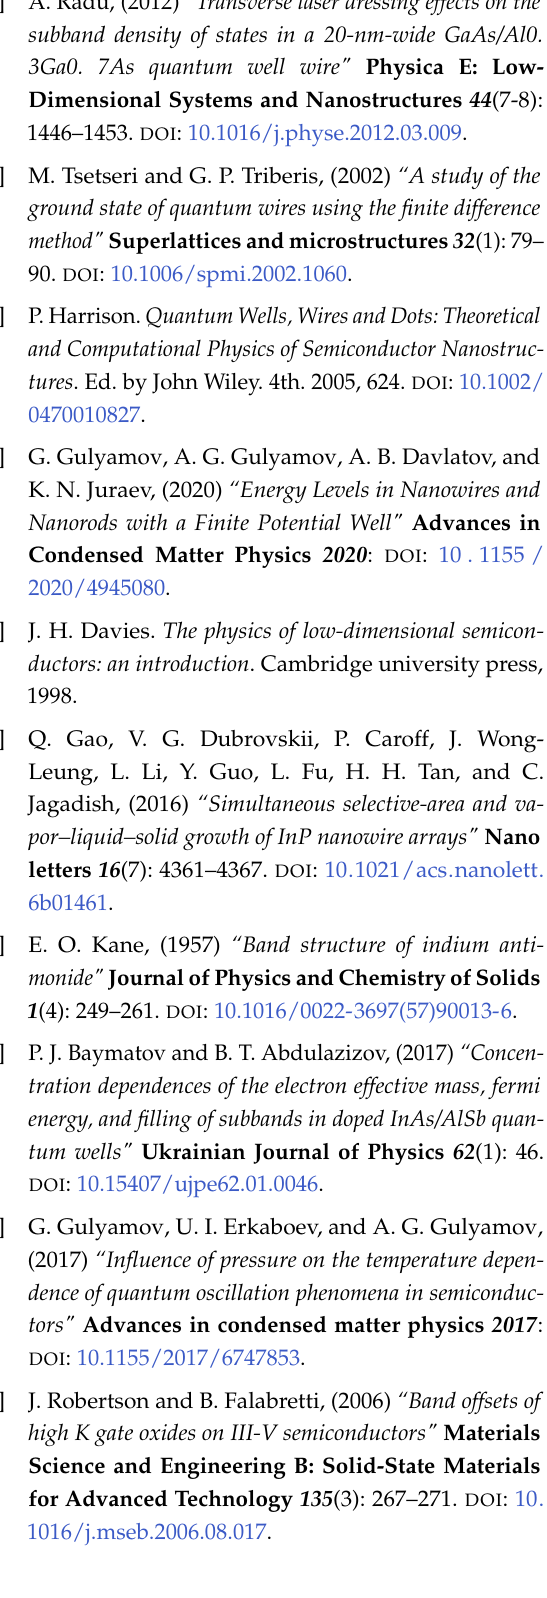
Table 1. Material parameters of InAs and InP Parameter InAs InP